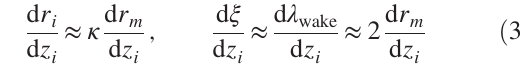
FIG. 3. (a) The transverse forces experienced by a sample of the sheath electrons with initial positive x i . (b) The trajectories of the electrons in the transverse phase space. The initial positions ð x ¼ x Þ are indicated by dots. The solid lines are for a uniform plasma i (no injection) while the dashed line is for a sample injected electron in a downramp. The electrons in (a) and (b) have y i ≈ 0 and the same colors correspond to the same electrons. The normalized charge density distribution of the injected electrons in r − z ξ − z i i plane (c) and i plane (d). The lines are from Eq. (3). The beam parameters are the same as in Fig.